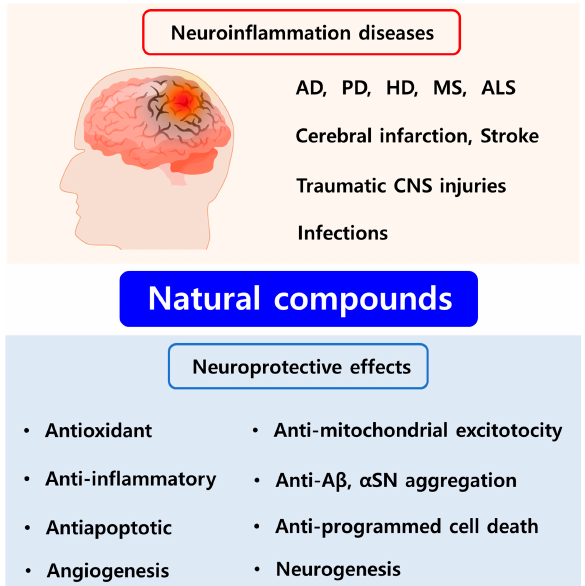
Figure 2. Various therapeutic e ff ects of natural compounds in neuroinflammation. Alzheimer’s disease (AD); Parkinson’s disease (PD); Huntington’s disease (HD); Multiple sclerosis (MS); Amyotrophic lateral sclerosis (ALS); Central nervous system (CNS); Amyloid β protein (A β ); α -synuclein ( α